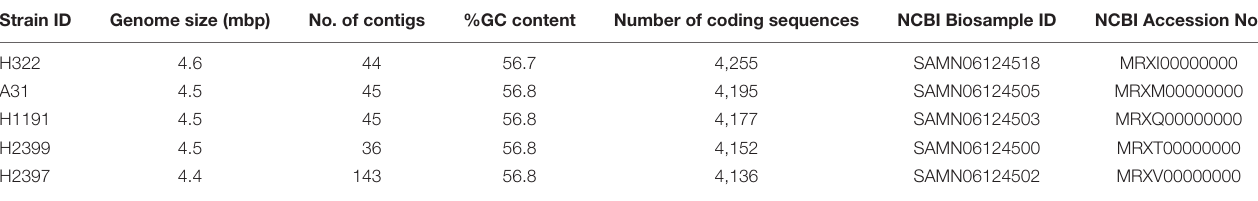
TABLE 2 | Overview of whole genomic characteristics of the C. sakazakii ST83 strains used in this study. Strain ID Genome size